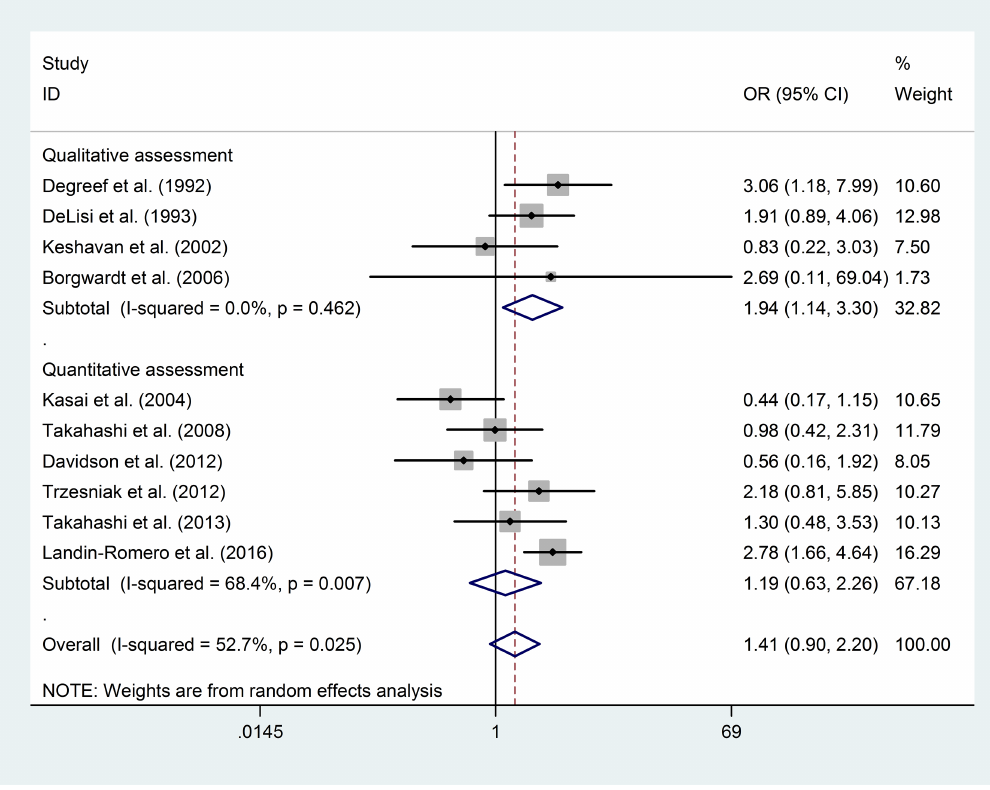
Fig 3. Prevalence of “any CSP” in FEP patients and healthy